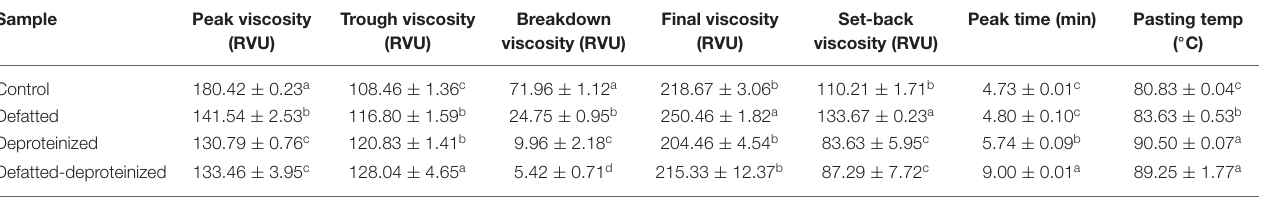
TABLE 4 | Pasting properties of control, defatted, deproteinized, and defatted-deproteinized sorghum flour samples.